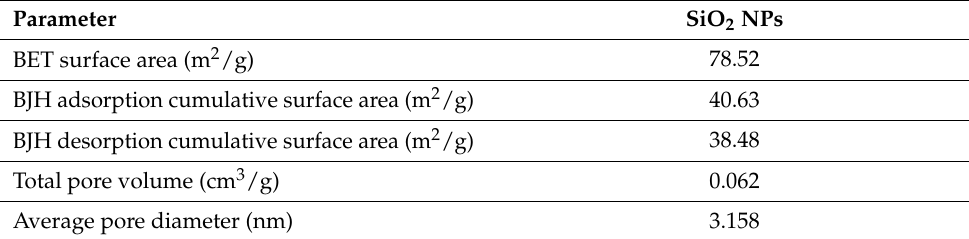
Figure 7. Nitrogen adsorption–desorption isotherm of the prepared SiO 2 NPs, the blue line represents the adsorption branch, and the red line refers to the desorption branch of the isotherm. Table 2. BET surface area, BJH cumulative surface area, and total pore volume of SiO 2 NPs sample.